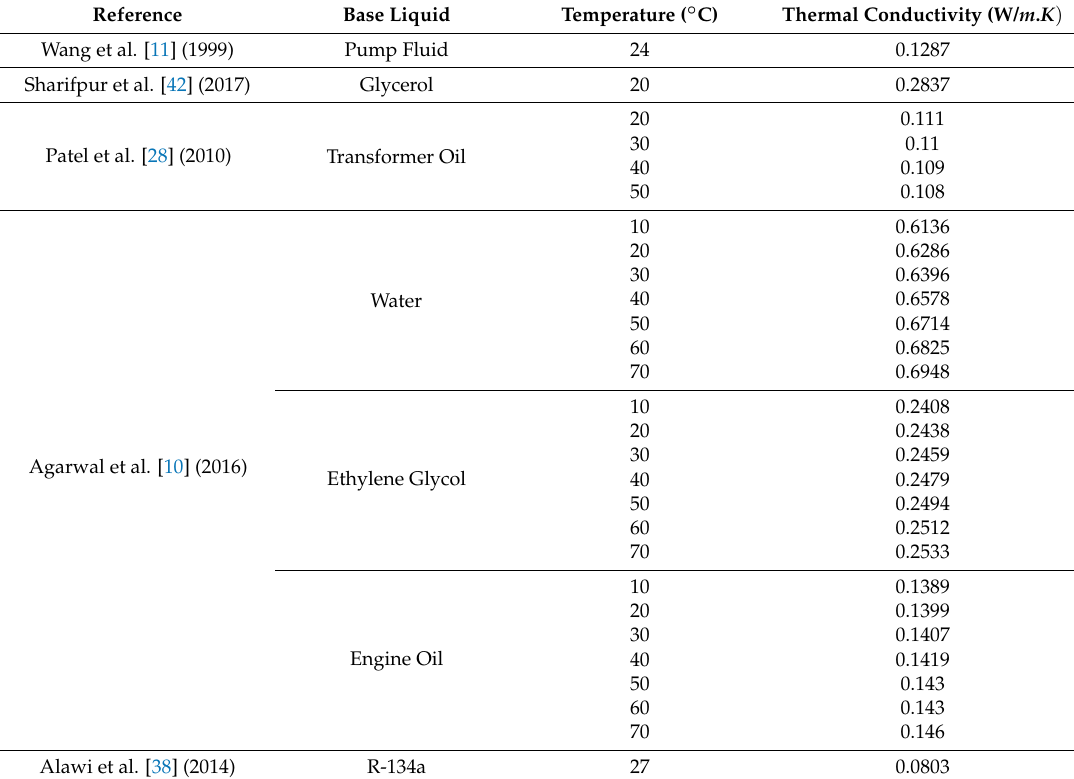
Table 2. Thermal conductivity of base